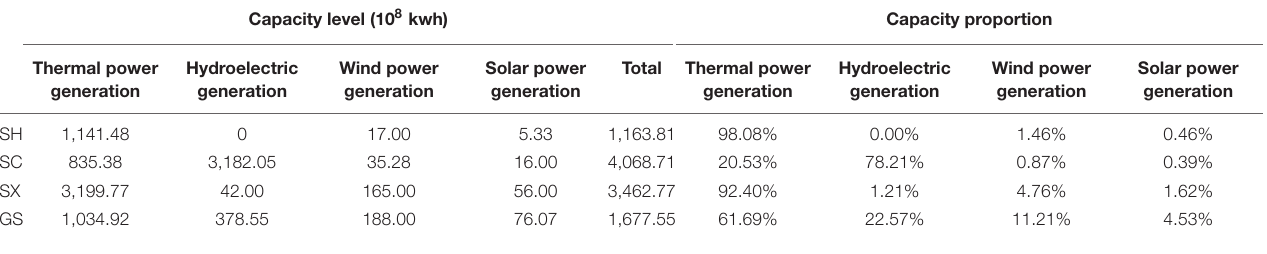
TABLE 3 | Capacity structure of electricity-generation in sample